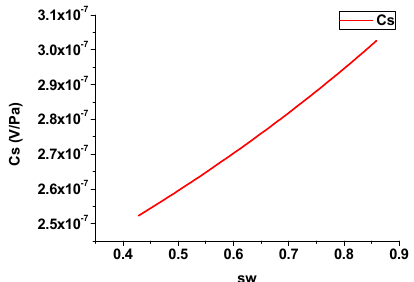
Figure 8. Variation of streaming potential coupling coefficient with saturation (slug flow).